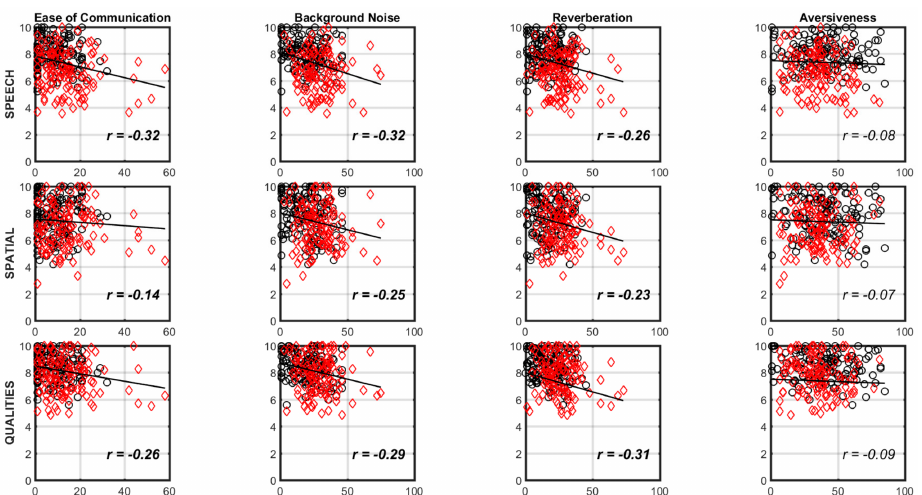
Figure 2. The top row shows the scatterplot between the speech SSQ subscale and the four APHAB subscales, the middle row shows the scatterplot between the spatial SSQ subscale and the four APHAB subscales, the bottom row shows the scatterplot between the qualities SSQ subscale and the four APHAB subscales. The x-axis represents scores from the subscales of the APHAB questionnaire while the y-axis represents scores from the subscales of the SSQ questionnaire. The open black circles indicate data from younger listeners, while the open red diamonds indicate data from older listeners in all the panels. The solid black line inside the panel shows the best fit line for the data. Bold correlations inside the panels are significant at p <